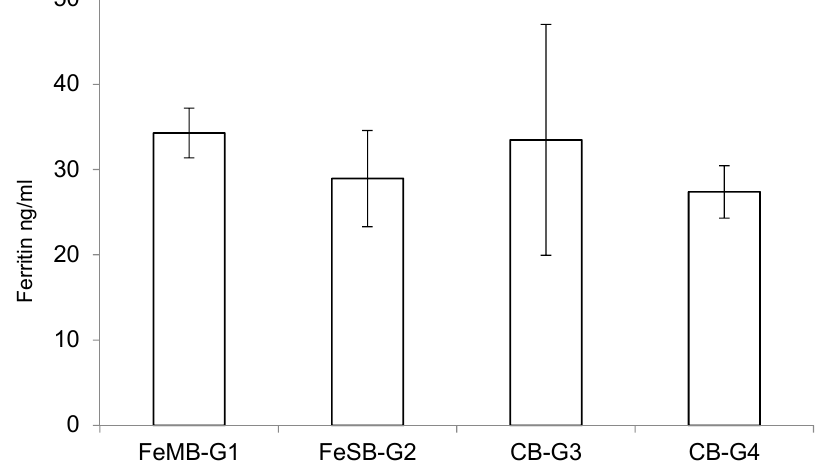
Figure 2. Effect of consuming different breads on plasmatic levels of ferritin in piglets.